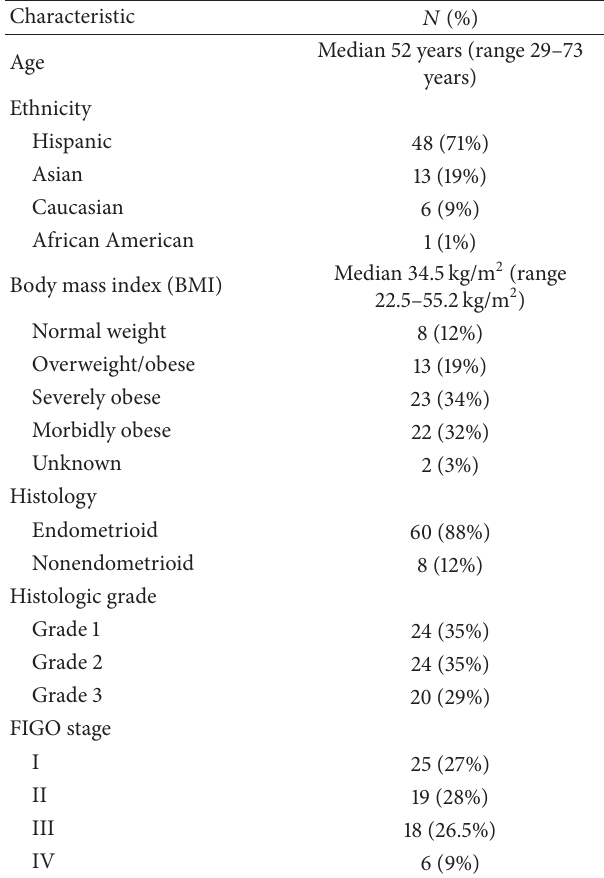
Table 1: Patient